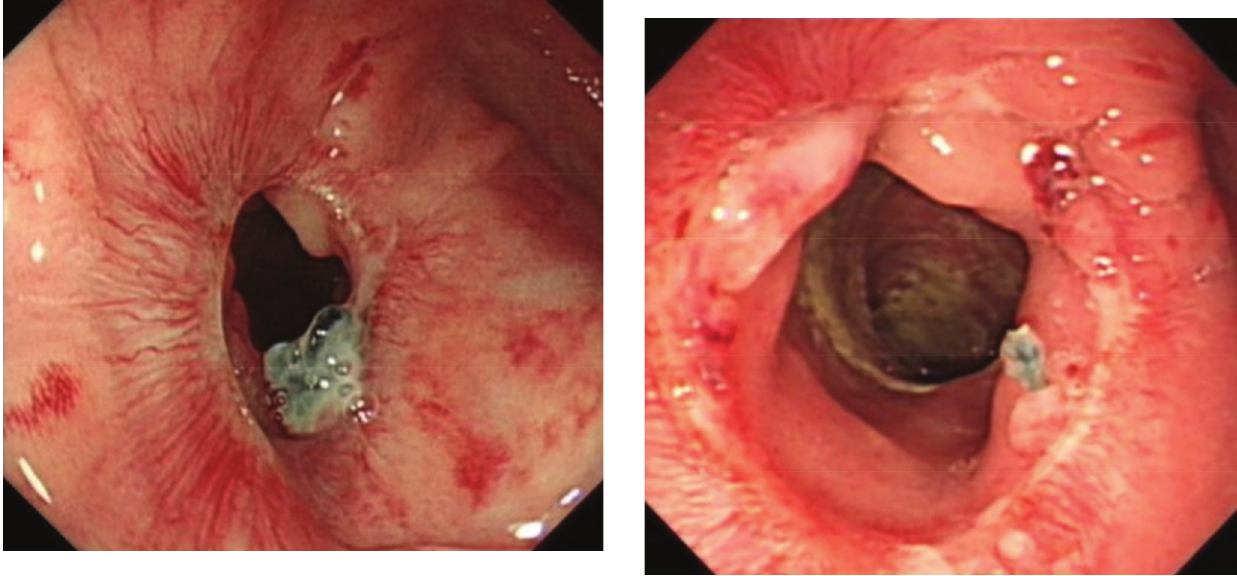
Figure 5 - The electronic colonoscopy view of the smooth anastomosis after 3 months postoperatively.